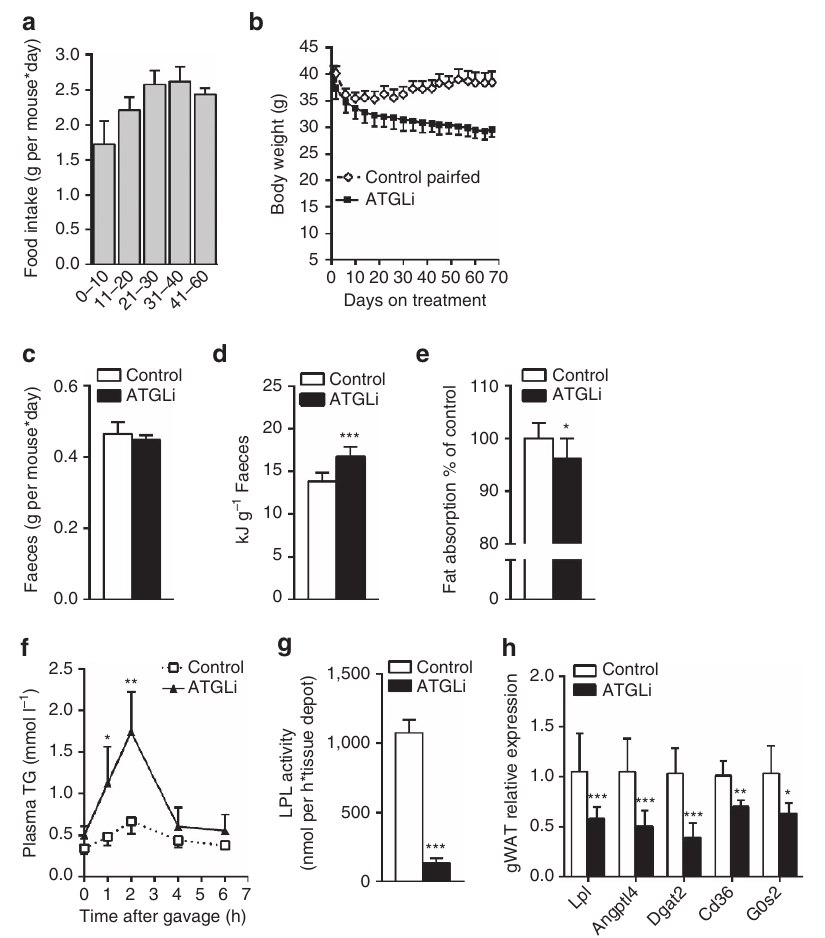
Figure 3 | Hypophagia and reduced lipid deposition in WATcontribute to the obesity resistant phenotype. ( a ) Six weeks old male C57Bl6J mice were fed a HFD (45kJ% fat; 22.1kJg (cid:2) 1 ) for 50 days. Thereafter, mice were fed a HFD in the presence or absence of Atglistatin for 68 days. Daily food intake in single housed mice was determined by subtracting food uneaten from food given to the bottom of the cages. Pair-feeding was performed by giving control mice the same amount of food ATGLi animals have eaten the day before ( ± 0.1g; n ¼ 5 per group). ( b ) Body weight of pair-fed and ad libitum -fed animals. ( c ) Faeces output was determined on 3 consecutive days ( n ¼ 8 per group). ( d ) Faeces of mice were sampled on 3 consecutive days and analysed for the excreted energy using a bomb calorimeter ( n ¼ 8 per group). ( e ) Lipid absorption was determined on 3 consecutive days using sucrose